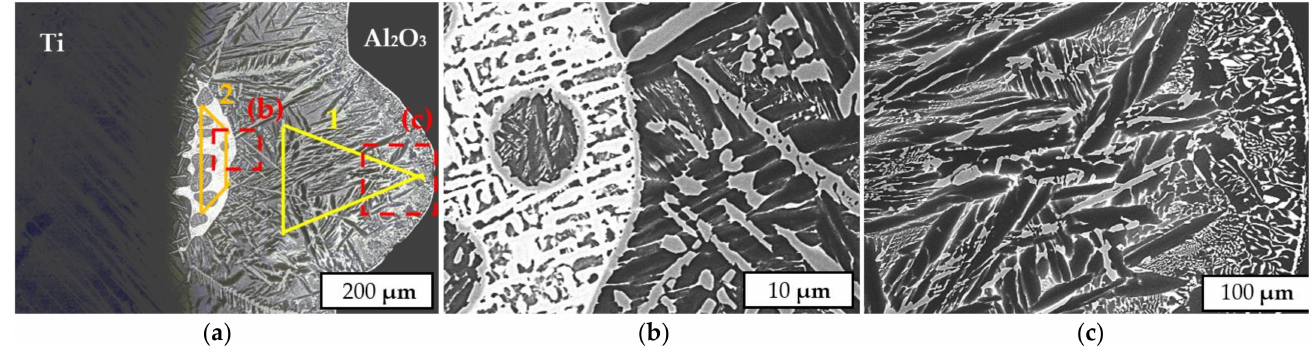
Figure 10. SEM-BSE images of the brazed seam in a notch located in the center of the sample, showing the general microstructure ( a ), a dendrite crystal zone ( b ) and a columnar crystal zone ( c